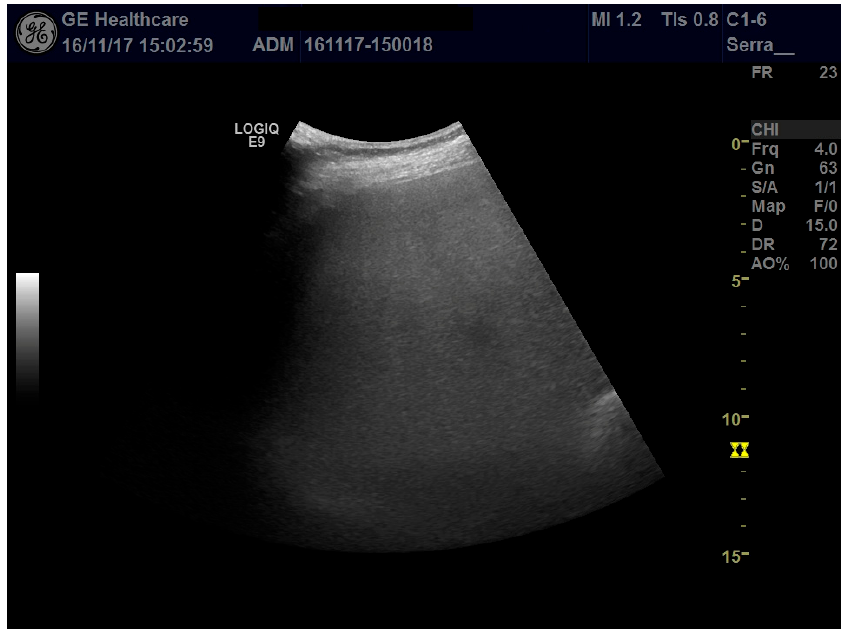
Figure 1. Ultrasound examination of the right liver lobe: the enlarged liver appears typically as “bright”, with fine, closely packed echoes without visualization of the vessels, as in the case of se- vere hepatic steatosis.